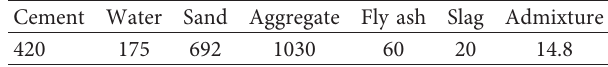
Table 1: Concrete mixtures (unit: kg/m 3